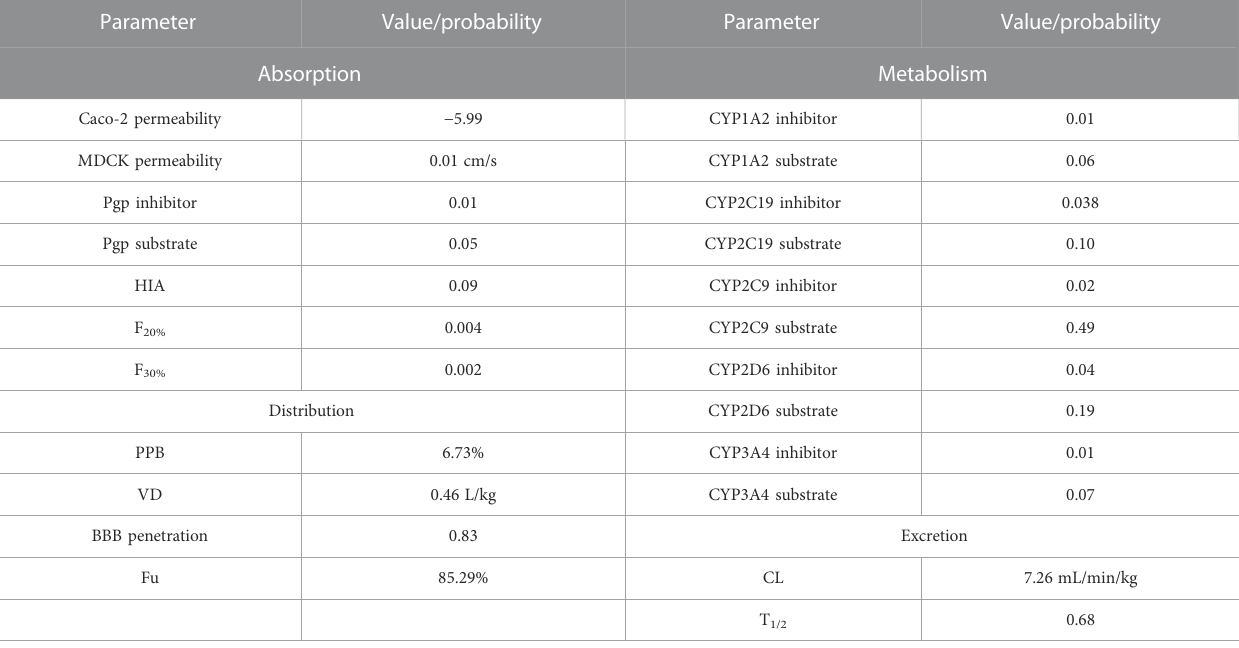
TABLE 3 Pharmacokinetics of 4-Hydroxy isoleucine calculated with ADMETLab 2.0. Parameter